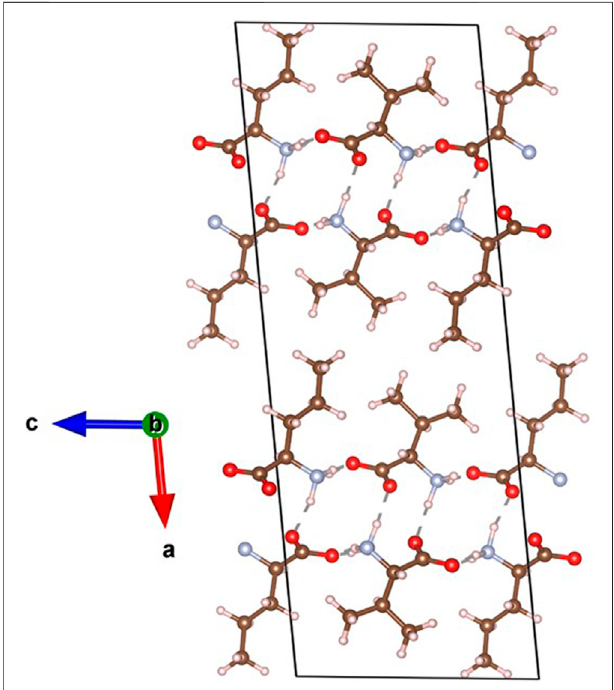
FIGURE 4 | Crystal structure of L-Valine, with molecules shown in CPK representation. Nitrogen atoms are coloured red, carbons are brown, hydrogens are white, and nitrogens are blue. Intermolecular hydrogen bonds are shown in dark